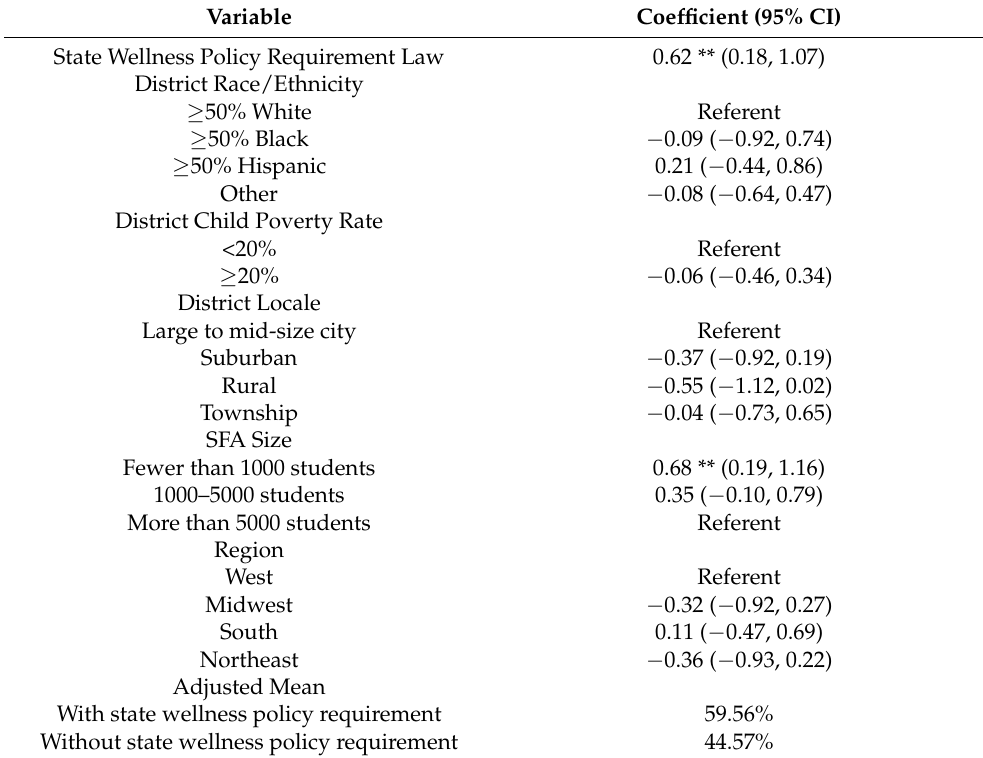
Table 3. Association between state wellness policy requirement law and SFA wellness policy full